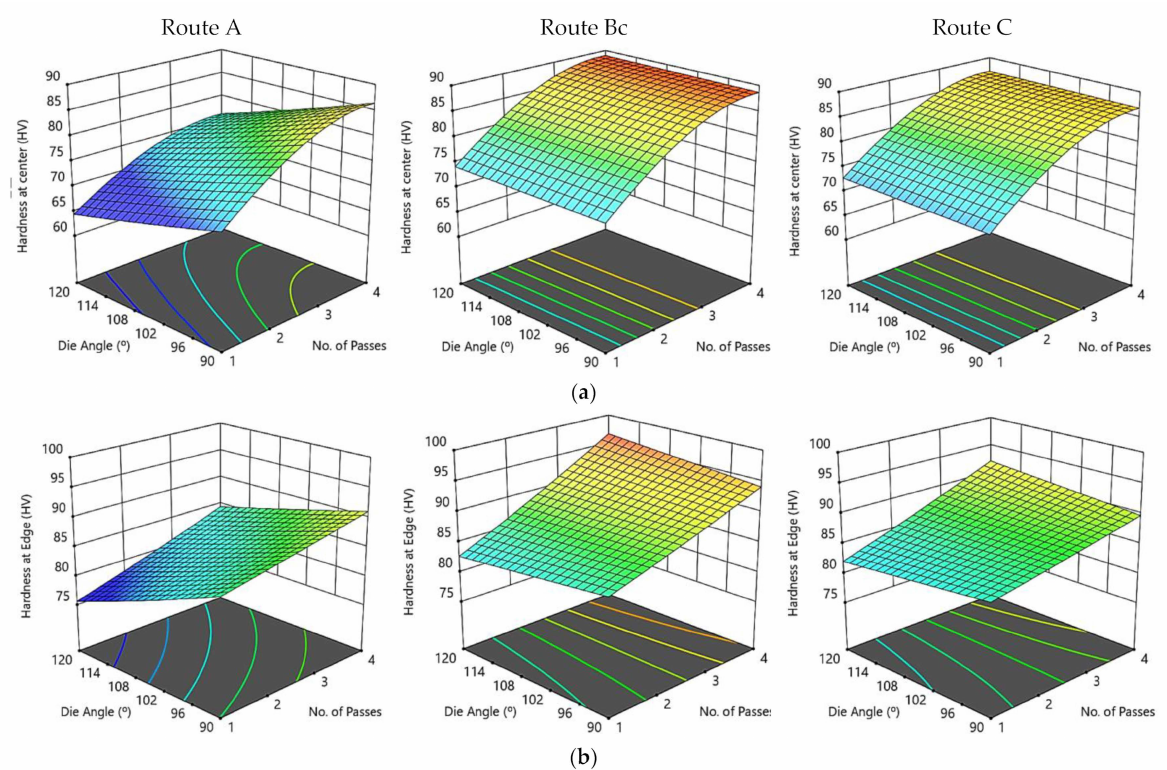
Figure 9. A three-dimensional plot of hardness at the center ( a ) and edge ( b ) with the ECAP die angle and number of passes for routes A, Bc, and